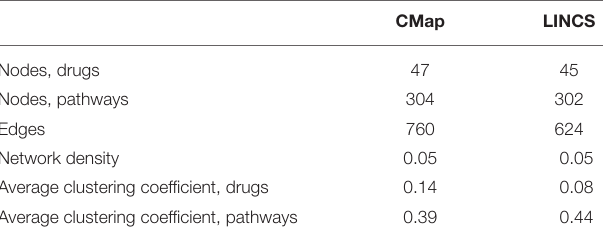
TABLE 1 | Graph parameters for drug-pathway perturbation